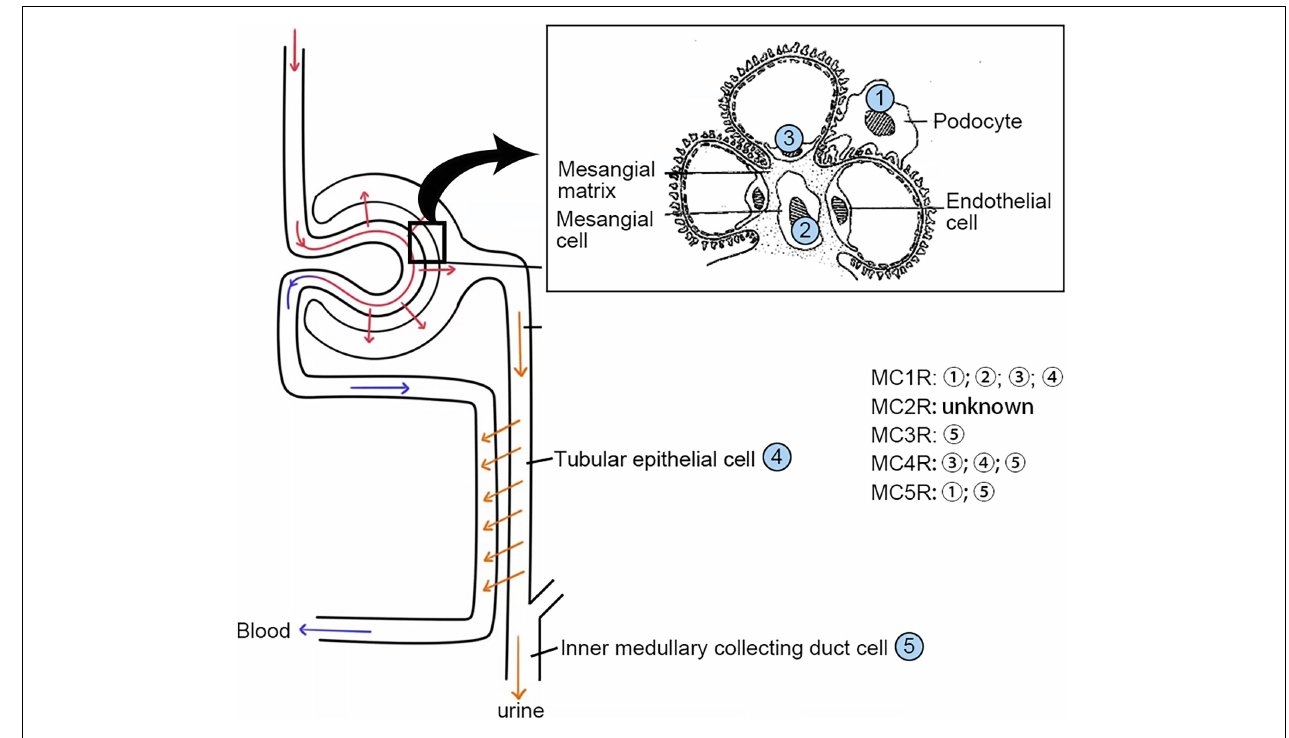
FIGURE 2 | Distribution of the MCRs in kidney cells. MCRs are widely expressed in renal parenchymal cells. MCR, melanocortin